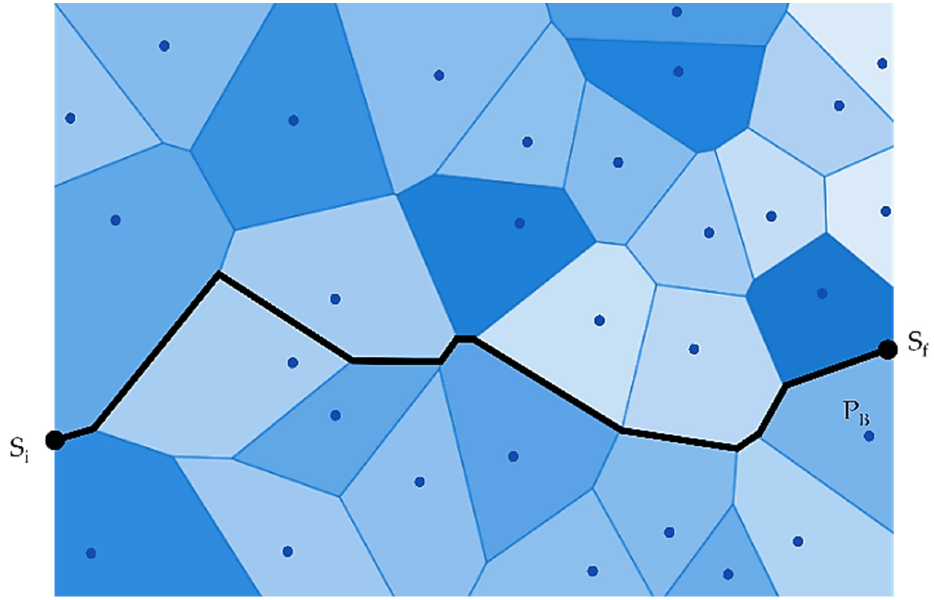
Figure 10. A maximal breach path (P B